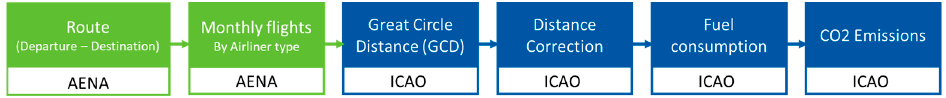
Figure 2. Flow chart research process. Source: own elaboration according to research design.